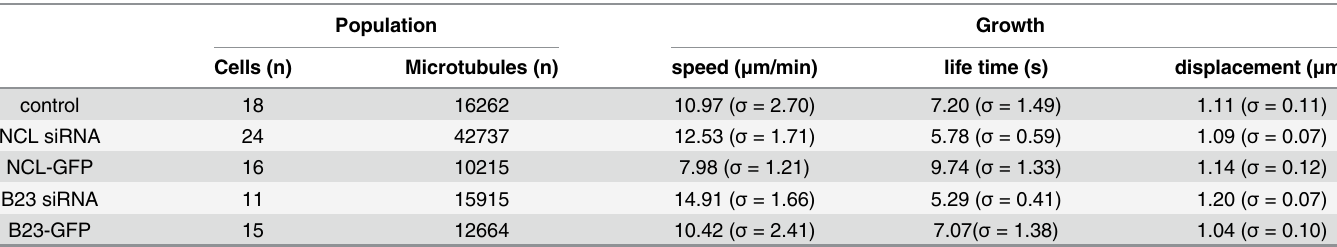
Table 1. Microtubule growth